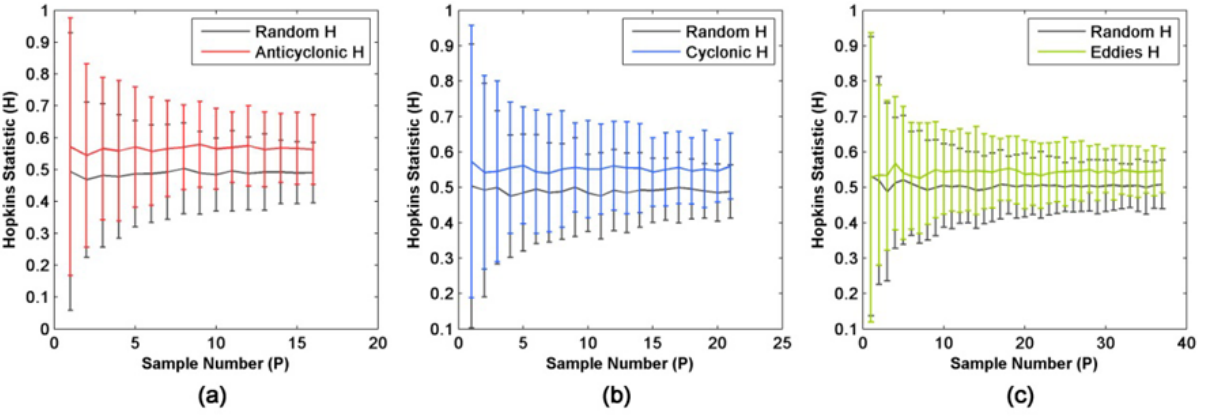
Fig. 2. Error bar plot of Hopkins statistic. Error bar is twice the standard deviation, and curve is mean of H . (a) Hopkins statistic of AE and random sample. (b) Hopkins statistics of CE and random sample. (c) Hopkins statistics of all eddies and random